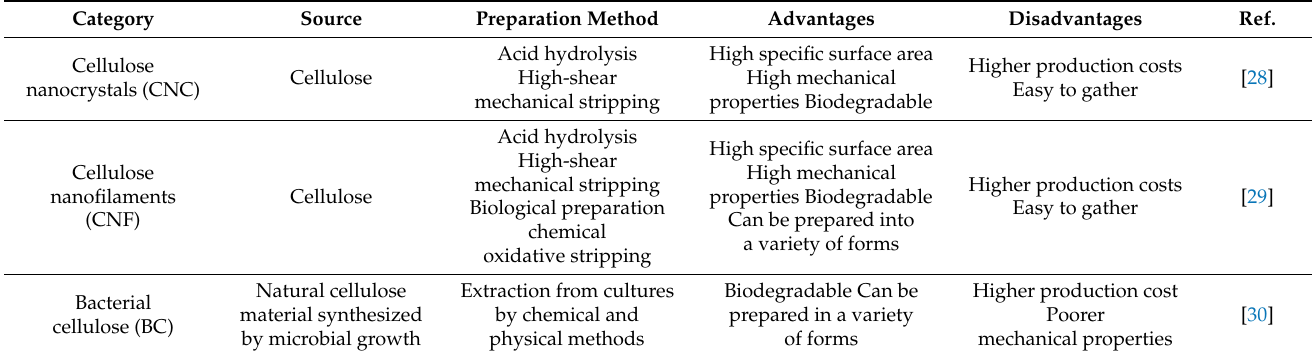
Table 1. Classification of nanocellulose.